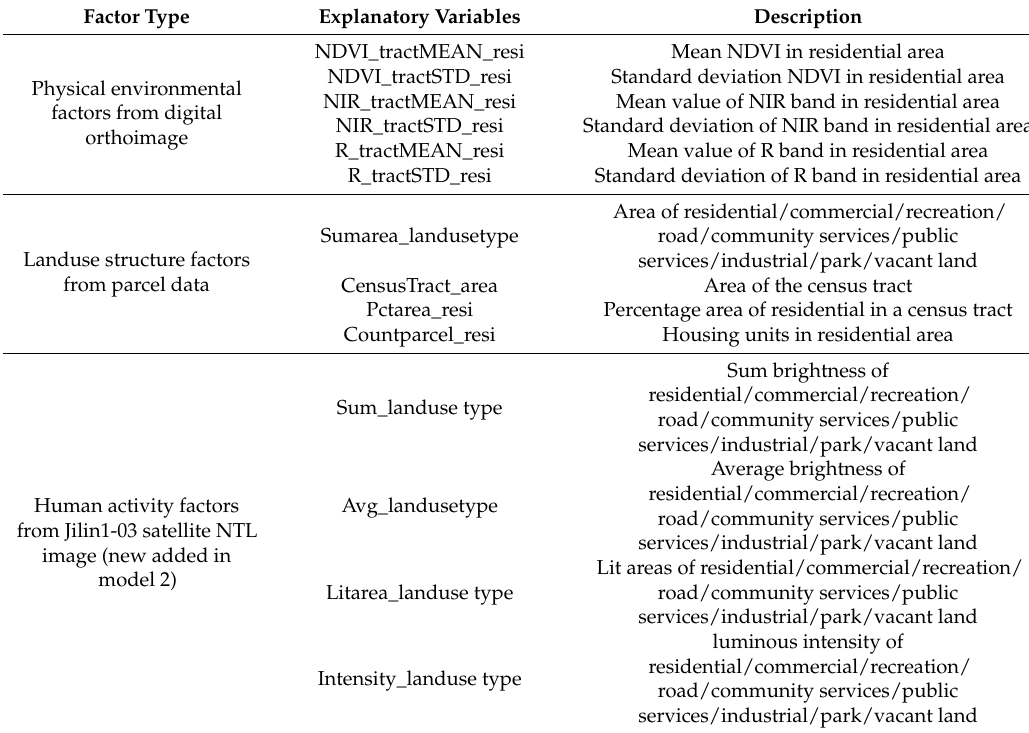
Table 3. Explanatory variables of the multivariate linear regression